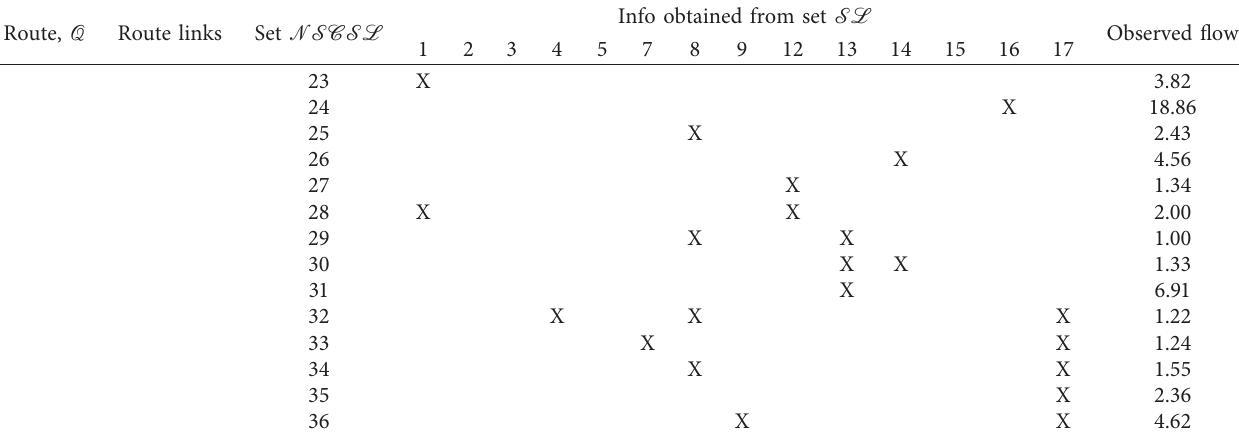
Table 2: New sets of combinations of scanned links ( NSCSL ) beside their values of observed flow. Route,